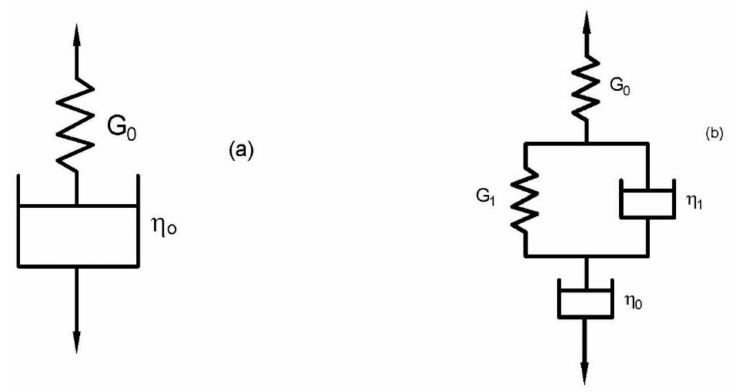
Figure 2. Maxwell and Burger models. ( a ) Maxwell model; ( b ) Burger